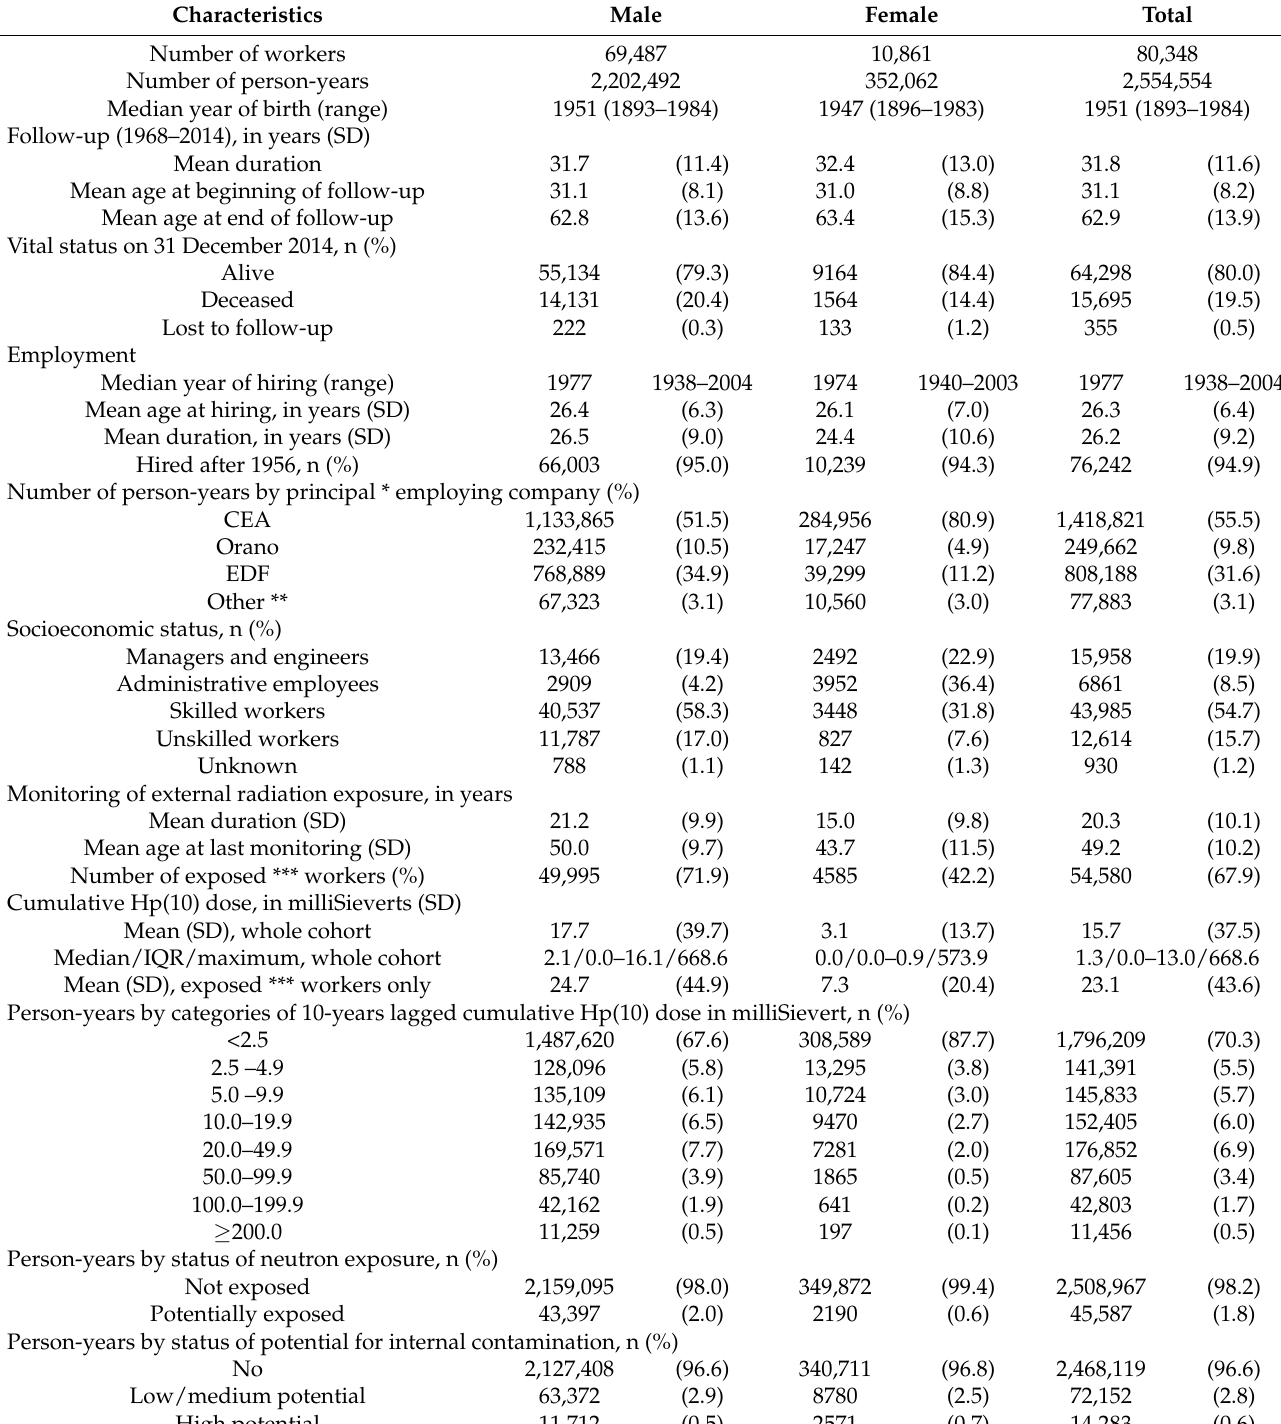
Table 1. Characteristics of the French nuclear worker cohort SELTINE, followed-up for mortality over period